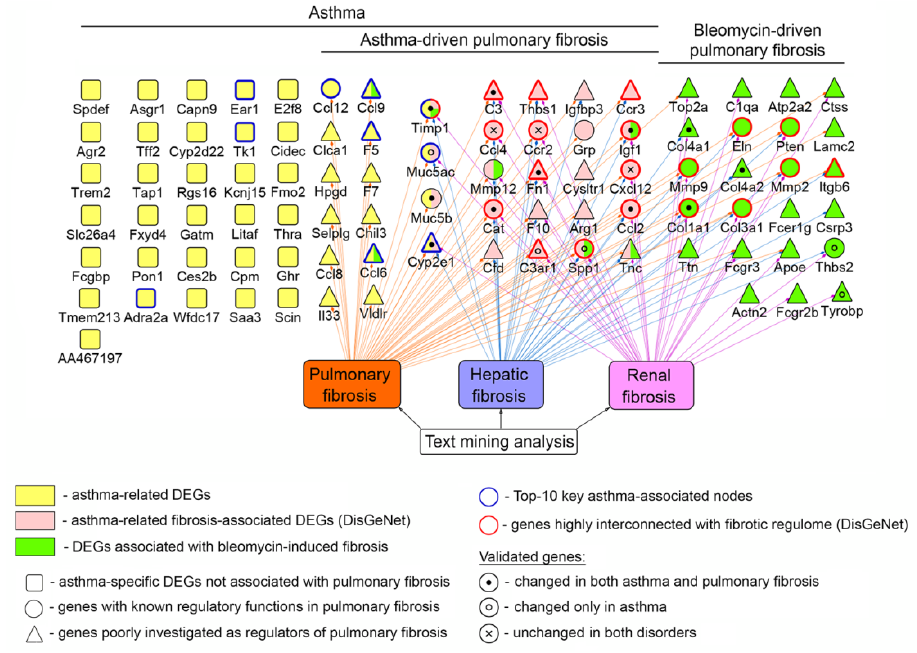
Figure 8. Interconnection of asthma-associated genes with pulmonary fibrosis regulome. It should be emphasized that only a part of the listed genes have been verified here